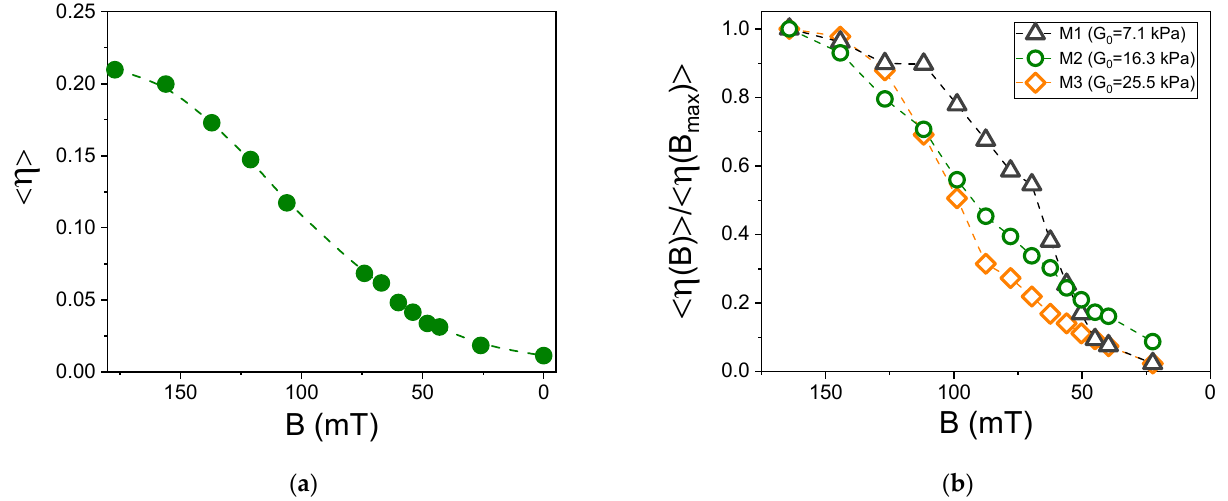
Figure 4. ( a ) Transversal profile of the far ‐ field optical diffraction patterns observed as outcomes of two separate embossing processes in sample M2. Both diffraction measurements were performed at B = 180 T. In between the two embossing episodes, the sample was removed from the magnetic field for several hours. ( b ) Far ‐ field optical diffraction pattern observed at B = 180 mT (thick green line) and at B = 40 mT (thin black line). The value of B was slowly reduced from 180 mT to 40 mT in steps of about 20 mT.